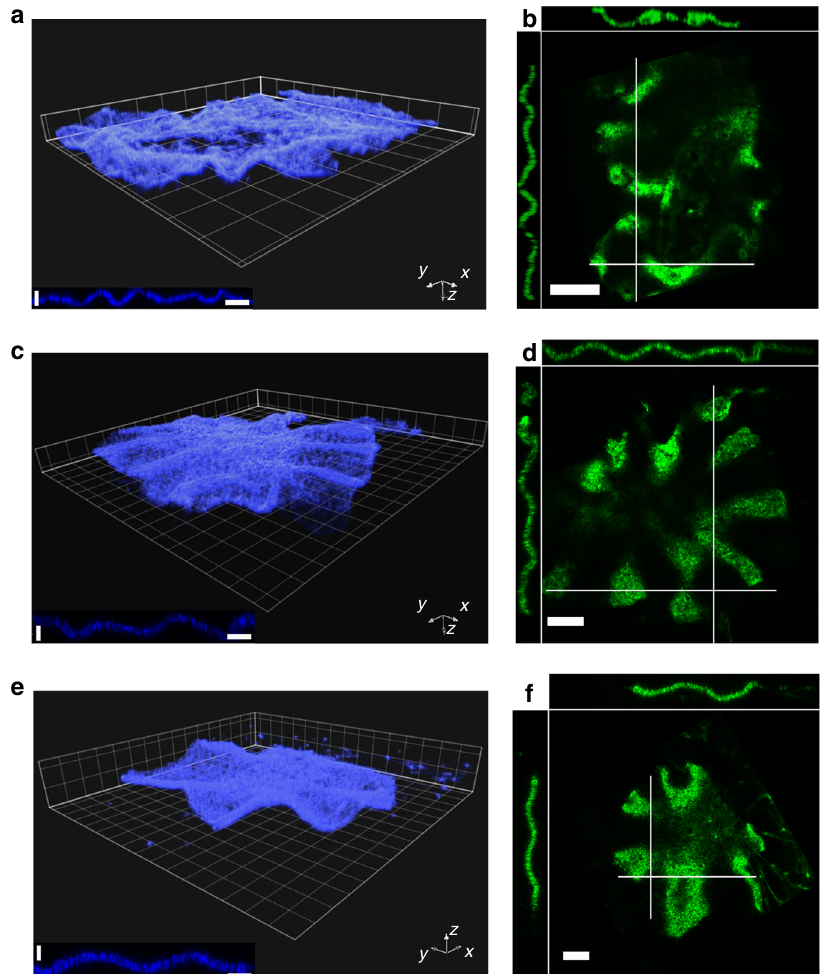
Fig. 6 Buckled gels of different thicknesses. a Three-dimensional reconstruction of a gel with fi nal sheet thickness b = 17 ± 2.5 μ m (mean ± SD) from laser scanning confocal fl uorescence micrographs. Errors for b indicate standard deviation of experimental values of the fi nal gel thickness measured at N = 93 different places across the gel surface (Methods). b Laser scanning confocal fl uorescence micrographs of the actin gel in a in the xy plane thicknesses (top view), the xz plane (top side view), and yz plane (left side view). Side views ( xz and yz planes) are measured along the white lines. c , d as in a , b but for a gel with b = 27 ± 3 μ m (mean ± SD, N thicknesses = 32). e , f as in a , b , but for a gel with b = 41 ± 2.5 μ m (mean ± SD, N thicknesses = 34). Chamber heights h